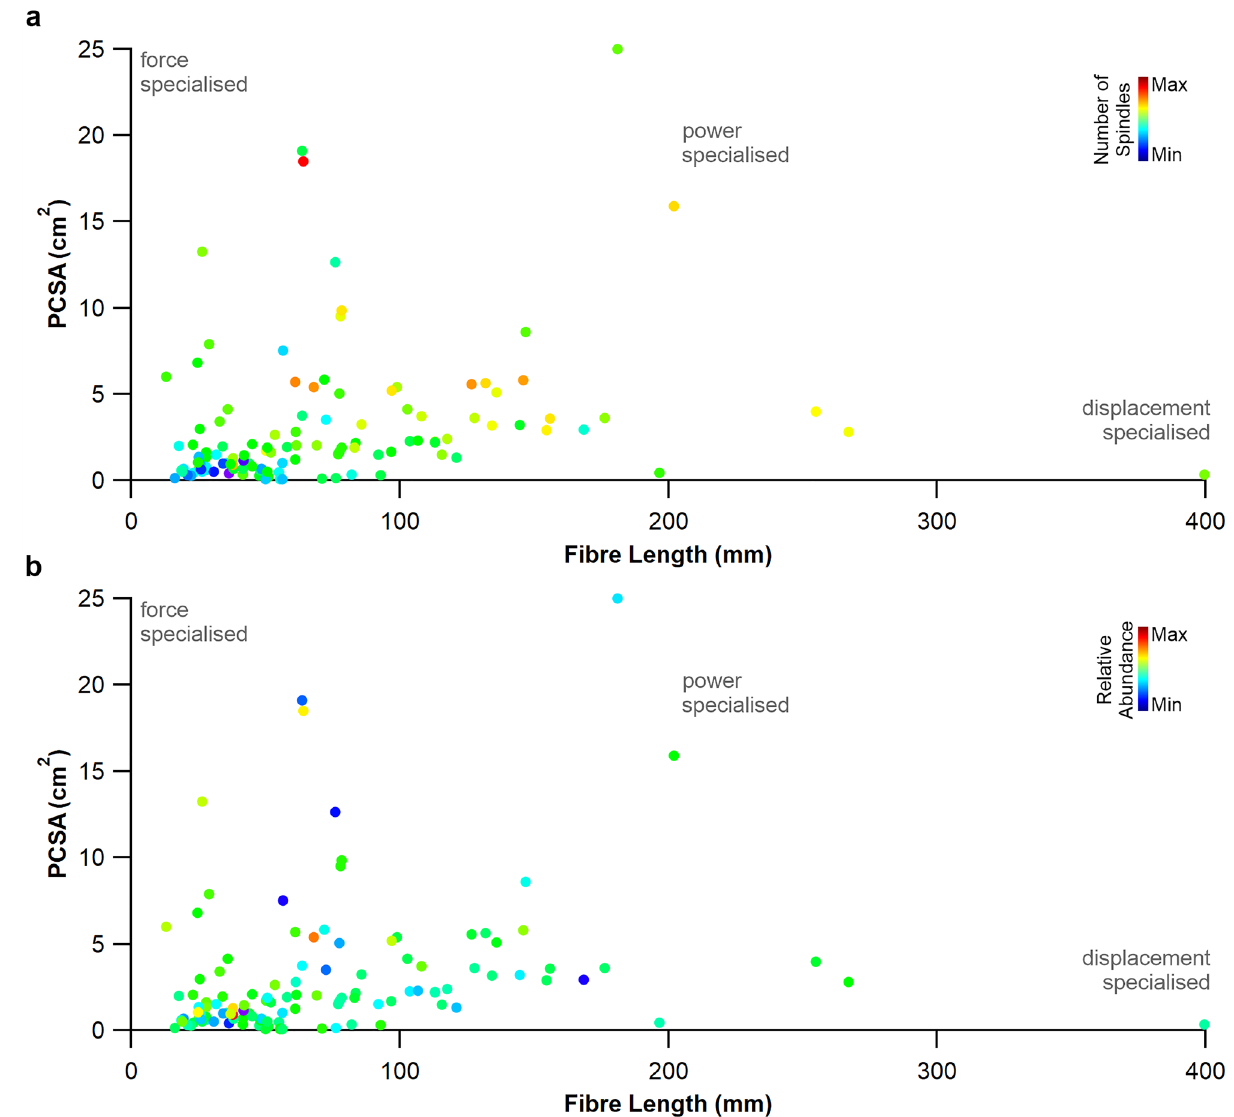
Figure 2. Morphospace plots show no correlation between muscle spindle composition with displacement specialists. Muscles that neither contain large absolute numbers of muscle spindles ( a ) nor are highly abundant in spindles ( b ) appeared to be preferentially optimised as displacement